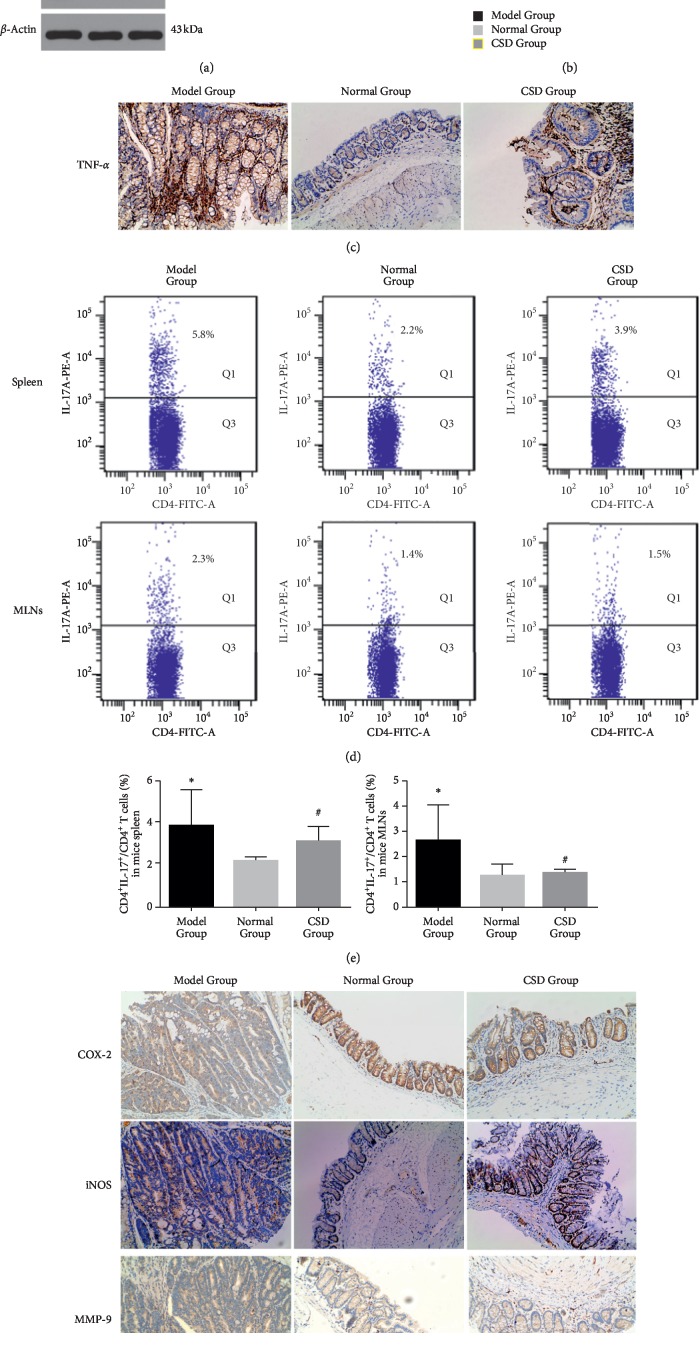
AOM/DSS-induced inflammatory response is impeded by CSD. (a) Western blot analysis of classical inflammatory proteins expression profiles in colon. (b) Representative histogram of densitometry analysis of the data derived from western blot, ∗∗p < 0.01, significantly different from the Model Group. (c) Immunohistochemical staining analysis of TNF-α expression in colons. (d) Representative flow cytometry dot plot of the percentages of CD4+IL-17+Th17 cells in CD4+ cells in the spleen and MLNs of each group. (e) Trends of Th17 cells in mice, ∗p < 0.05, #p > 0.05 vs. Model Group. (f) Effect of CSD on COX-2, iNOS, and MMP-9 expression in colon tissues in C57BL/6 mice.